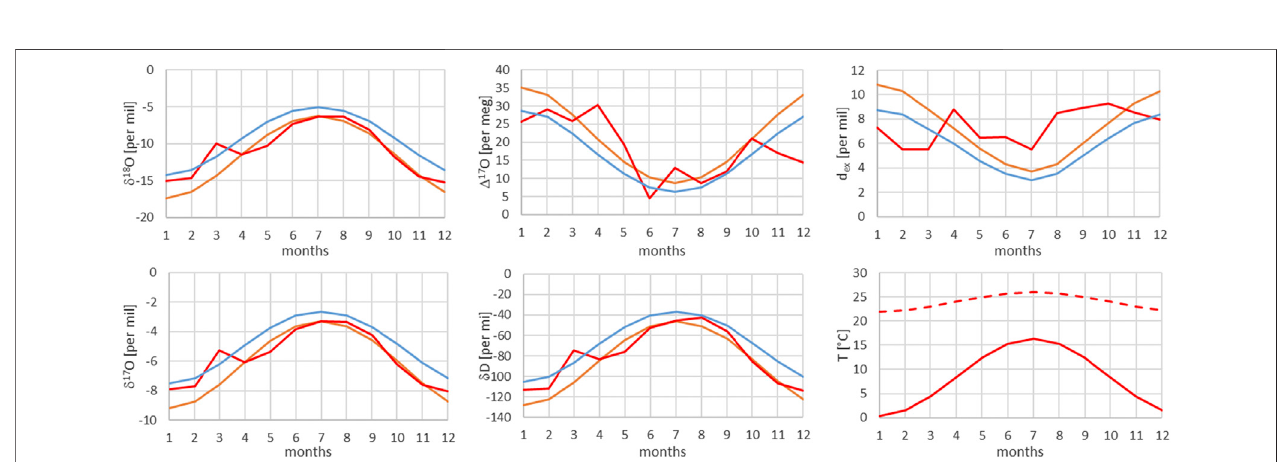
FIGURE 10 | Comparison of monthly mean measured (red) and modeled (for the isobaric case (orange) and for the dry adiabatic case (blue)) isotope ratios for Meiringen. The dashed red line corresponds to the assumed source temperature.